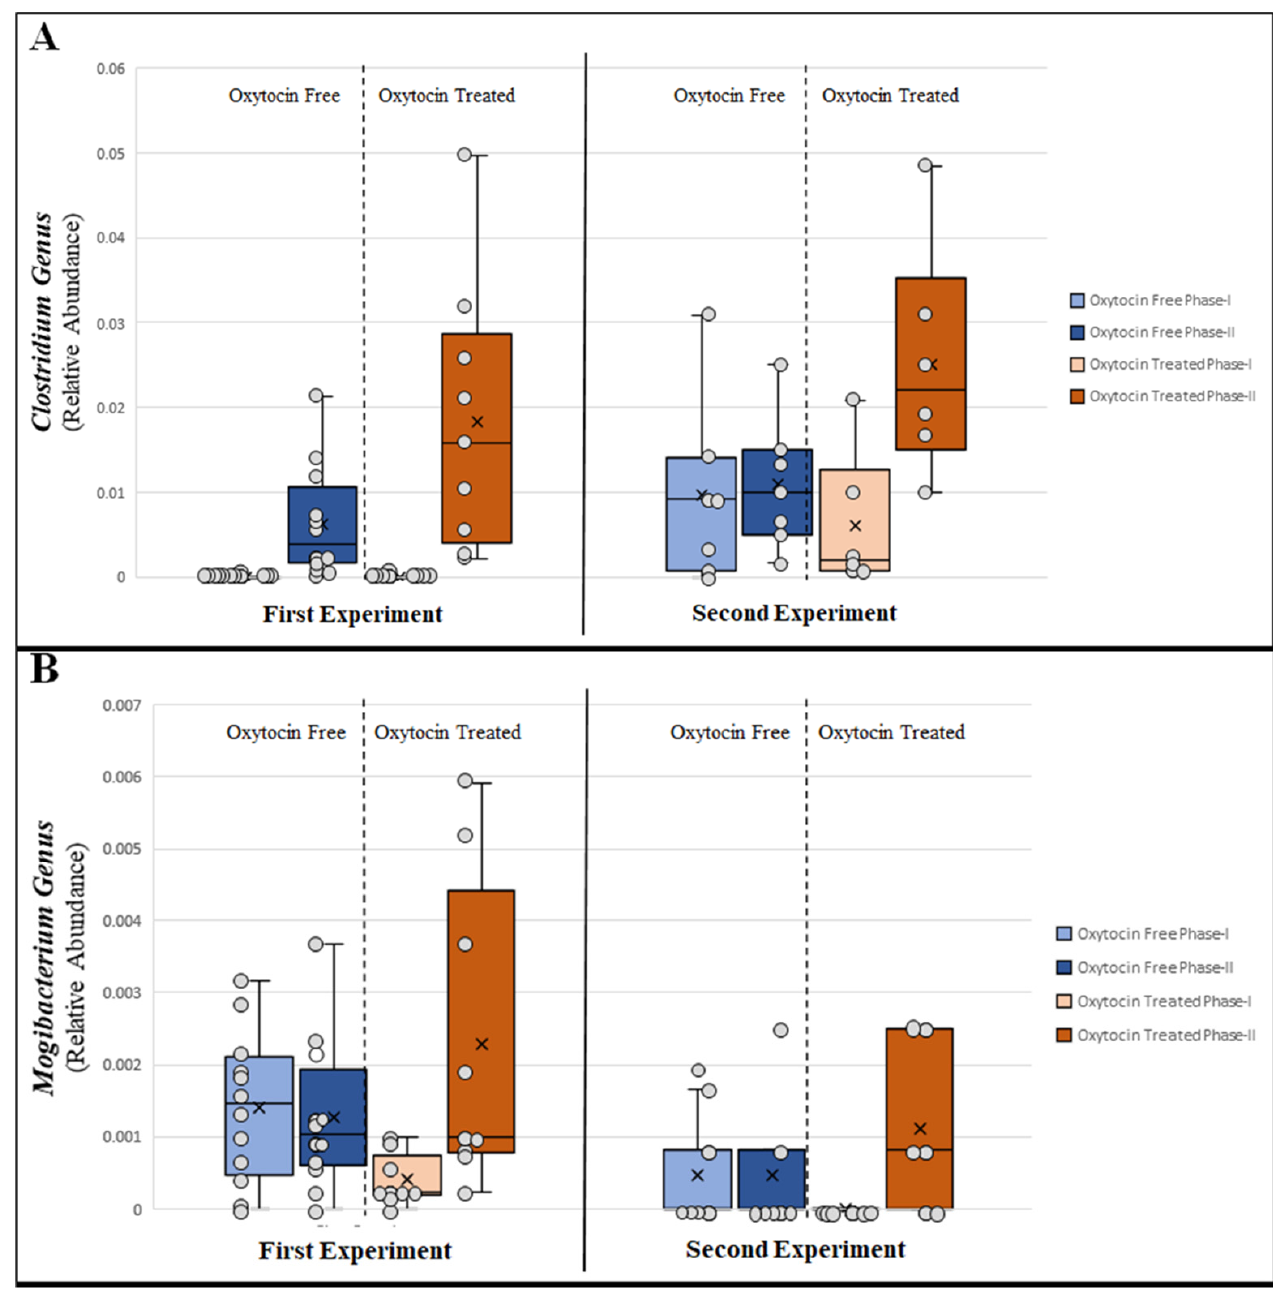
Figure 4. Bacterial genera significantly differentiating oxytocin-treated and non-treated groups: first experiment, each circle represents a single cage pool; second experiment, each circle represents a single animal; phase I, pre-treatment; phase II, post-treatment; ( A ) Clostridium ; ( B ) Mogibacterium .